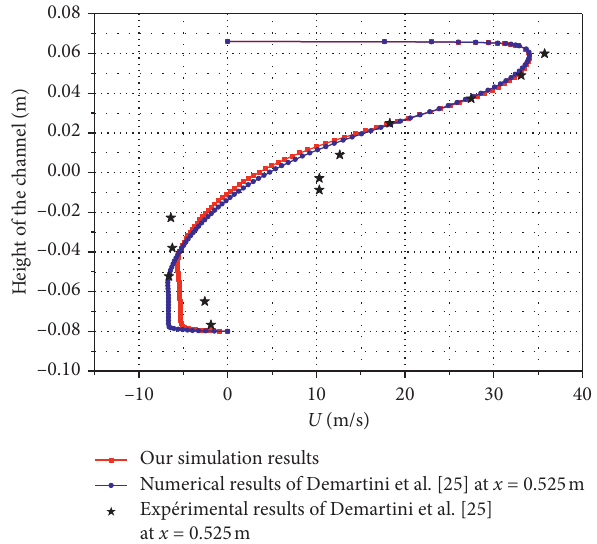
Figure 3: Axial velocity downstream of the second baffle at x �